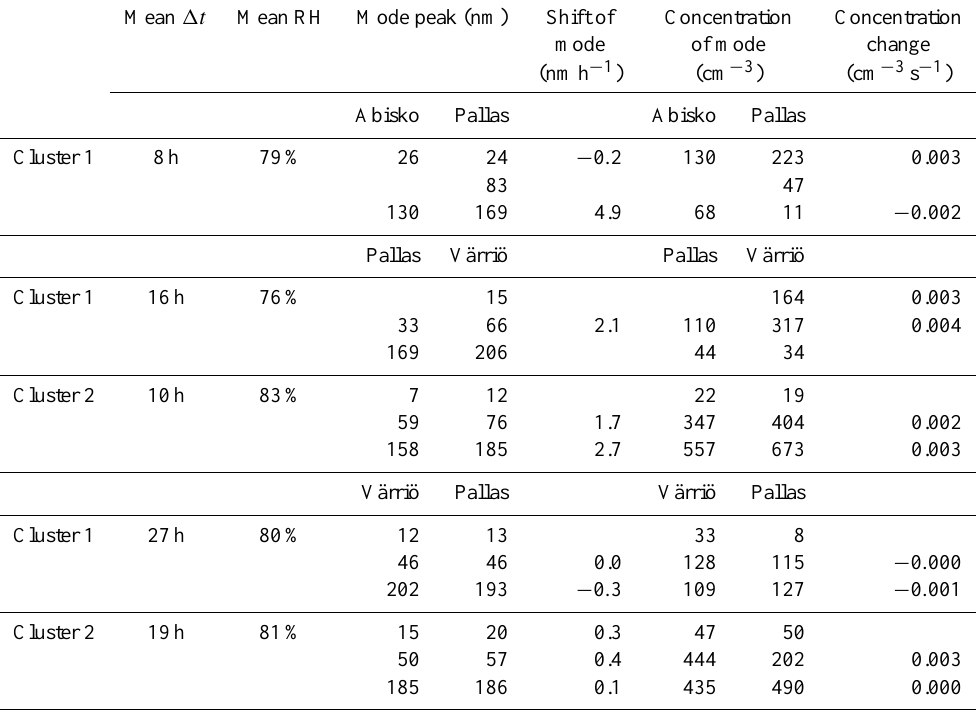
Table 5. Dynamics of particle number size distributions when air masses transport from one site to another. Similar to Table 4, but now covering the winter season. Mean 1t Mean RH Mode peak (nm) Shift of Concentration Concentration mode of mode change (nmh − 1 ) (cm − 3 ) (cm − 3 s − 1 ) Abisko Pallas Abisko